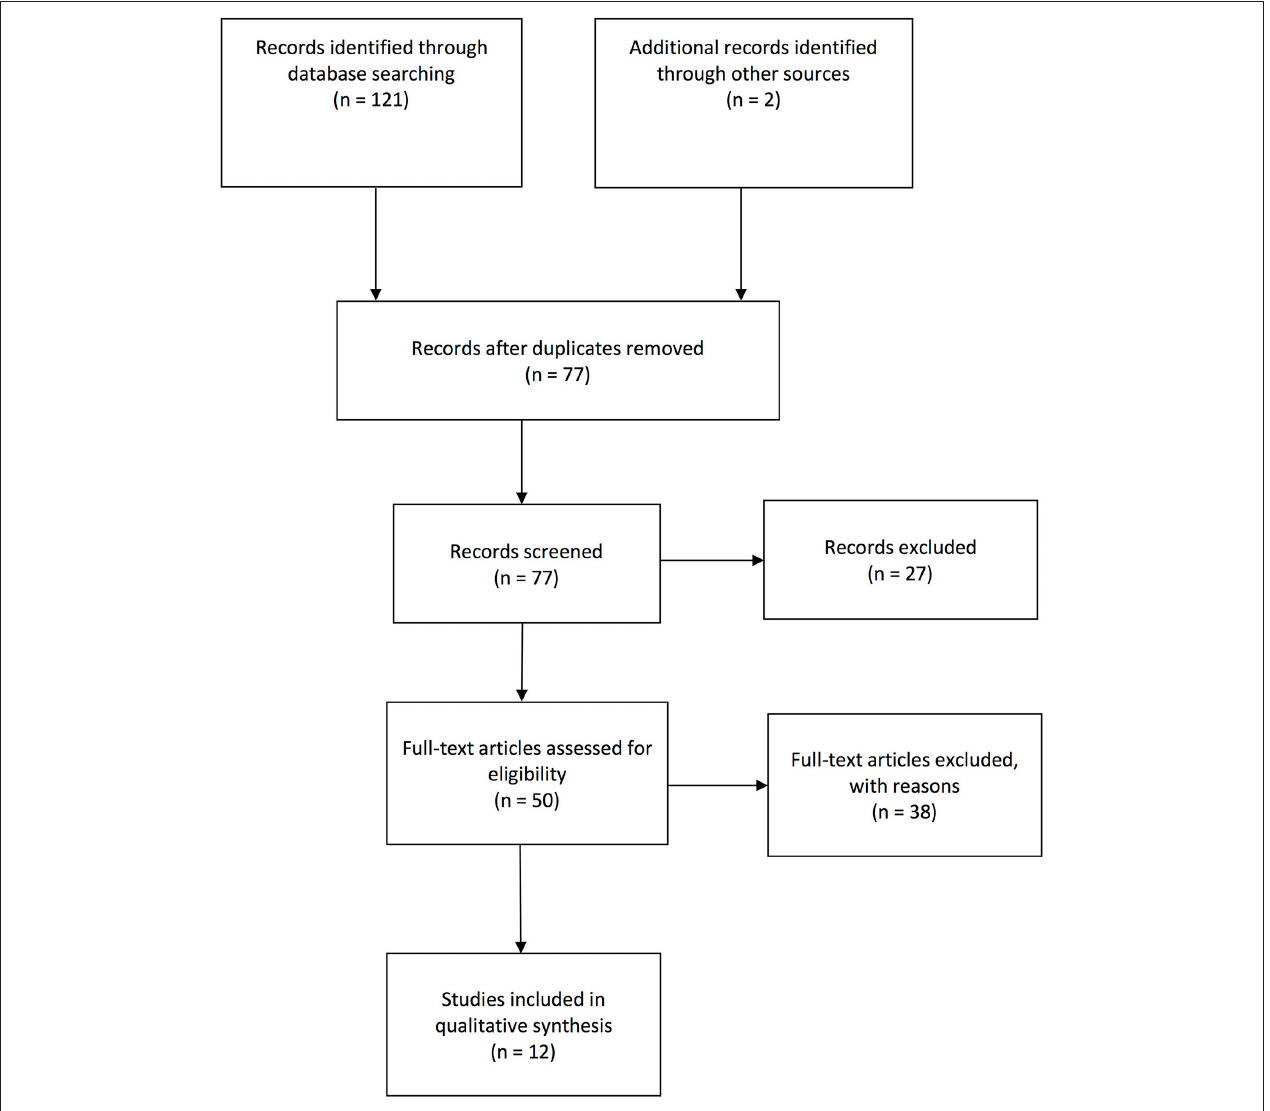
FIGURE 1 | Flow chart visualization of systematic search process according to PRISMA